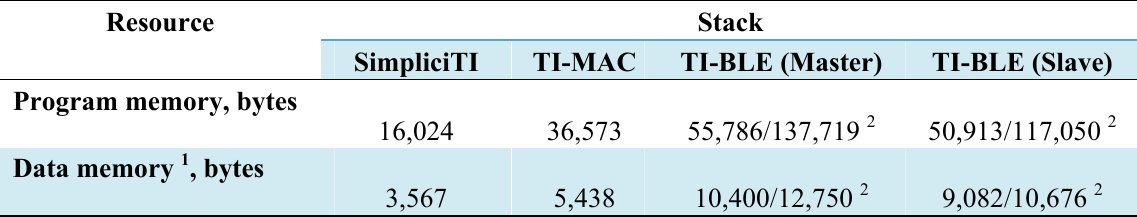
Table 3. Resources consumed by the